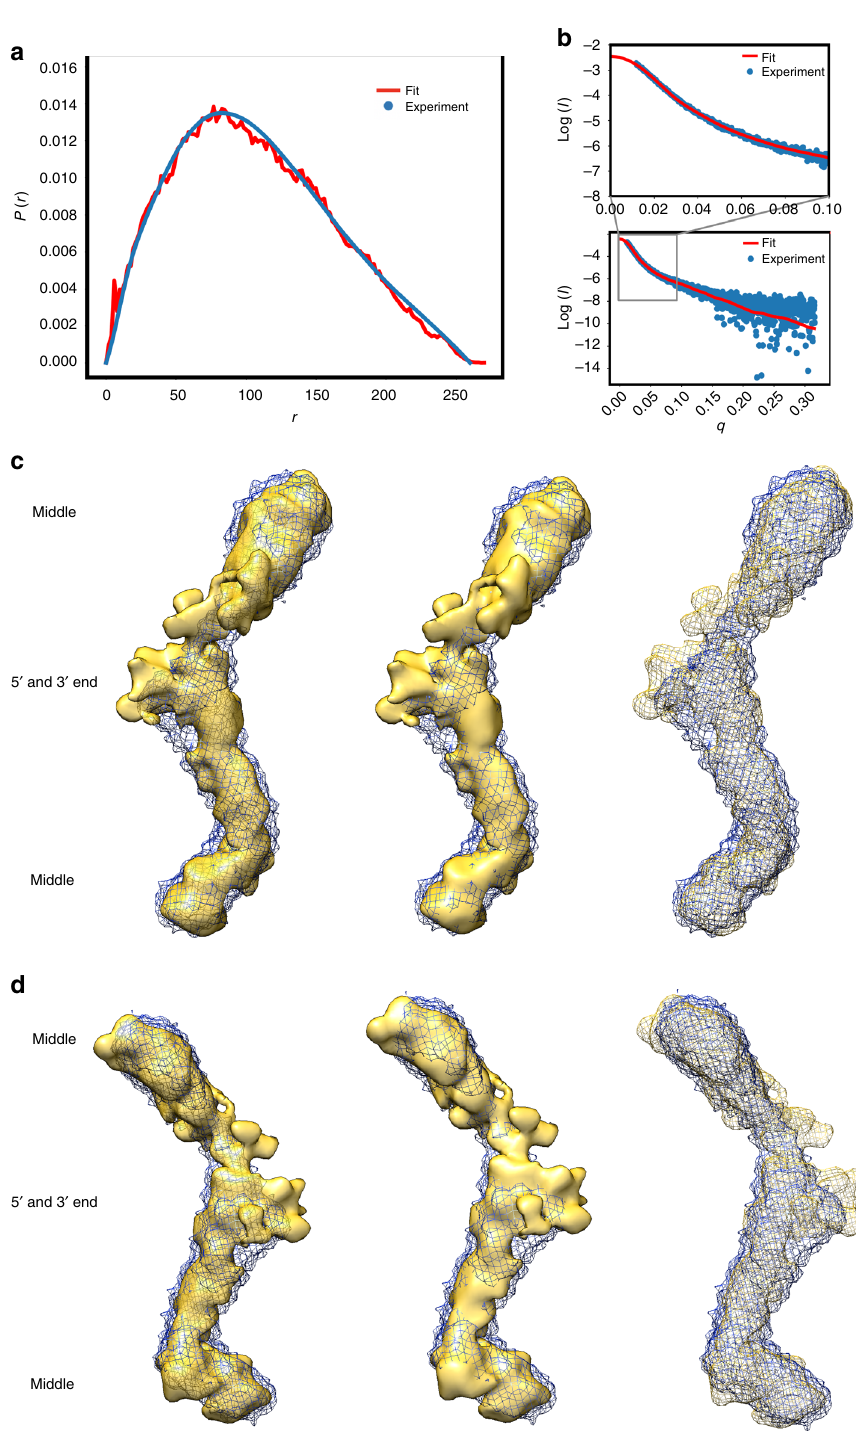
Fig. 5 Ensemble of atomistic models of Bvht matches measured SAXS data of Bvht at 12 mM Mg 2 + . a Pair-distance distribution function displays agreement between experimental data (blue) and data back-calculated from computational models (red). b Scattering intensity vs. angle indicates agreement between experimental and model derived data. c A comparison of averaged solution structures of full-length Bvht derived from SAXS data (meshed blue) and an ensemble of computationally derived atomistic models (yellow) shows agreement (Supplementary Fig. 6 and Supplementary Fig. 7). SAXS measured structure was rendered with two different surface opacities and with wire mesh to clearly display surfaces of both SAXS measured solution structure and solution structure of ensemble atomistic model (left, low opacity; middle, high opacity; right, yellow wire mesh). d 180° view of ( c ). See Supplementary Movie 1 for 360°